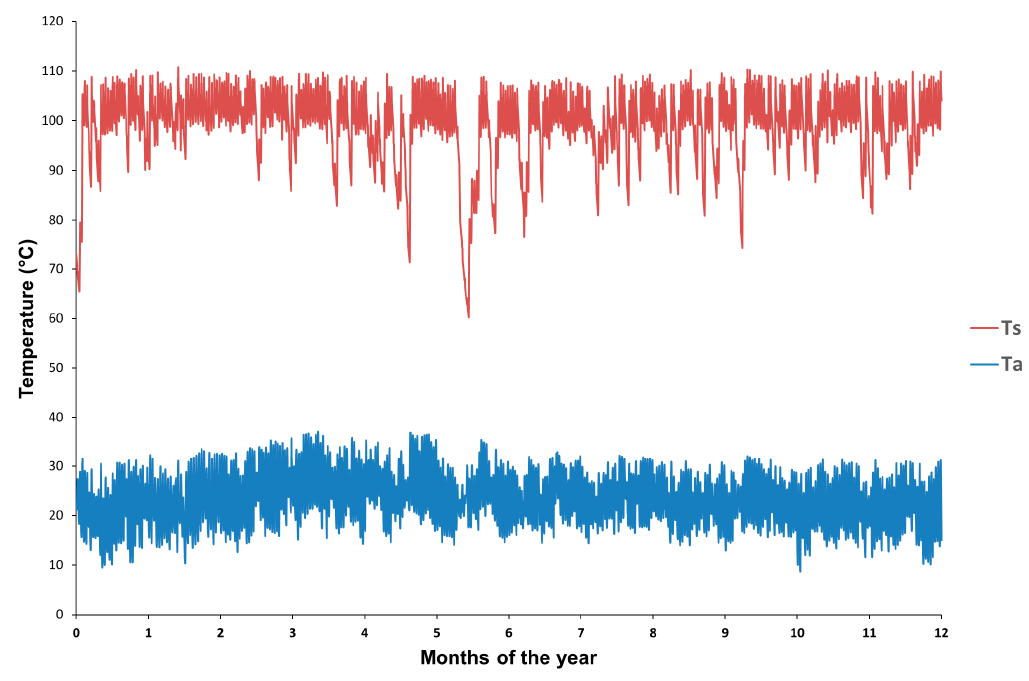
Figure 8. Water thermal profile and ambient temperature.